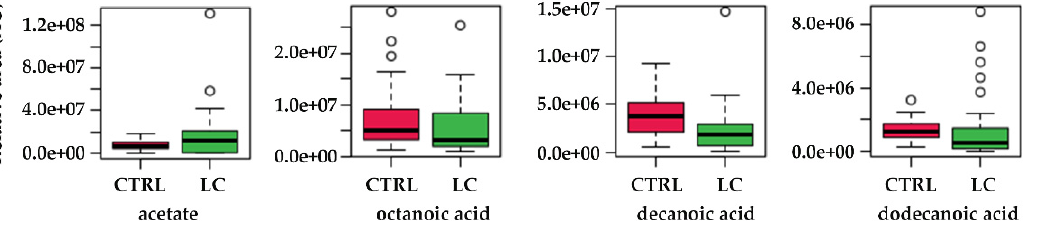
Figure 7. Boxplots of the variations found for the most relevant metabolites identified in the pathway topology analysis. CTRL—control subjects, LC—lung cancer patients.